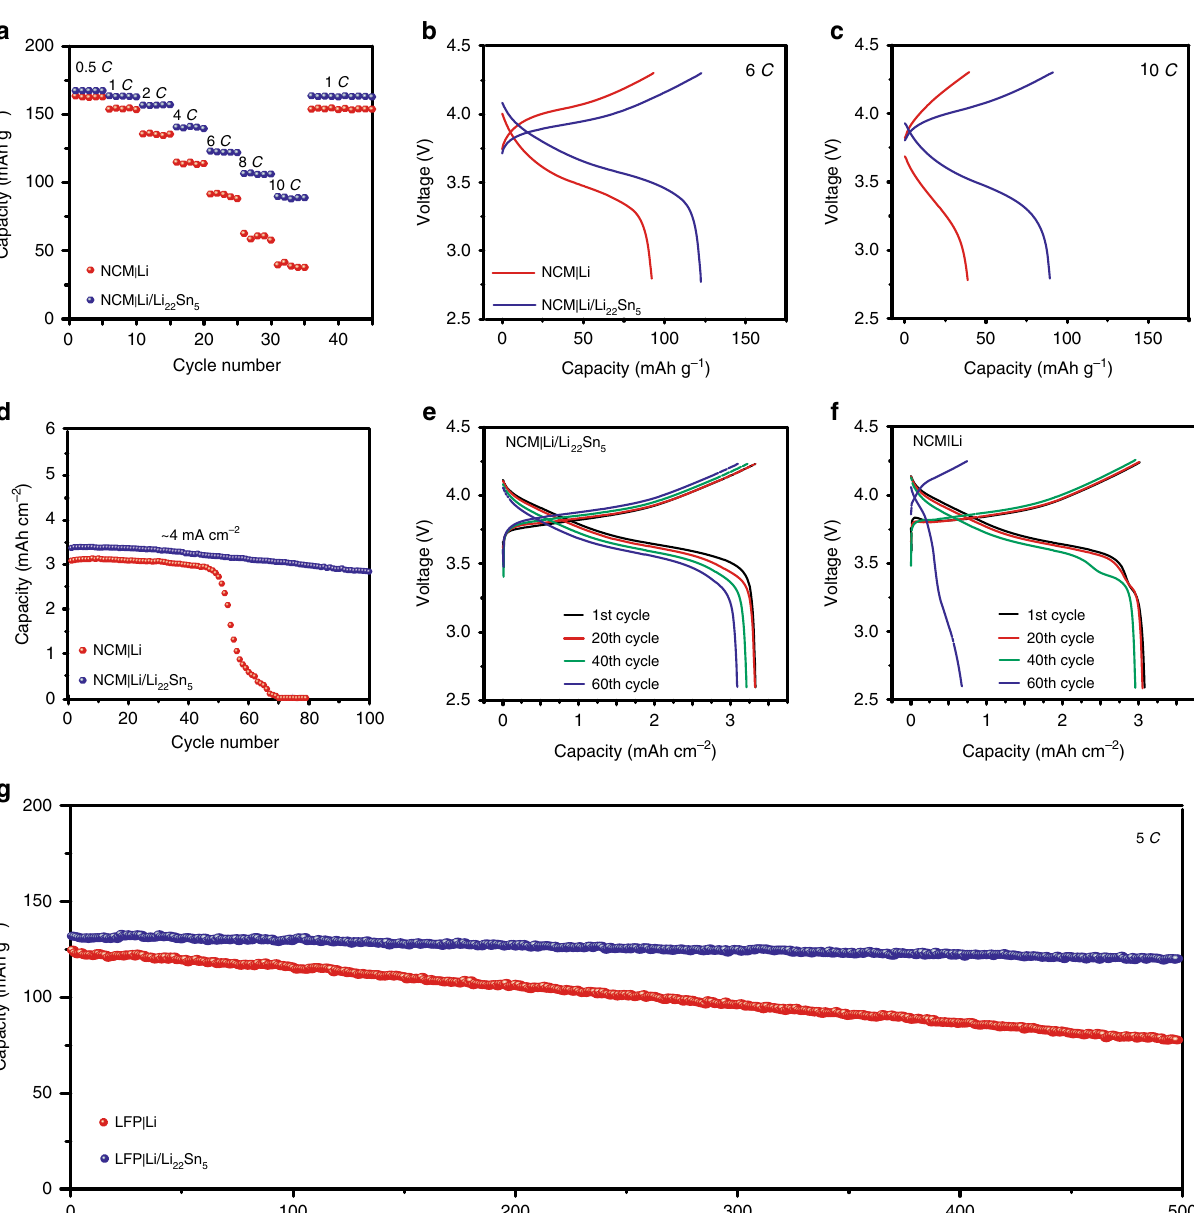
Fig. 3 Electrochemical performance of LiNi 0.6 Co 0.2 Mn 0.2 O 2 (NCM)|Li/Li 22 Sn 5 and LiFePO 4 (LFP)| Li/Li 22 Sn 5 cells. a Rate capability of the NCM|Li/ Li 22 Sn 5 and NCM|Li cells with NCM loading of ~6.5 mg cm − 2 at various rates from 0.5 to 10 C . b , c Voltage vs. capacity pro fi le comparison of the NCM|Li/ Li 22 Sn 5 and NCM|Li cells at rates of 6 C ( b ) and 10 C ( c ). d Capacity vs. cycle number pro fi les of the NCM|Li/Li 22 Sn 5 and NCM|Li cells with high NCM mass loading (~23.7mg cm − 2 ) and low areal capacity ratio of negative to positive electrodes (N/P ratio, 3.75). e , f Voltage vs. capacity pro fi les of the the NCM| Li/Li 22 Sn 5 ( e ) and NCM|Li ( f ) cells with high NCM mass loading and low N/P ratio for various cycles. g Capacity vs. cycle number pro fi les of the LFP|Li/ Li 22 Sn 5 and LFP|Li cells with LFP mass loading of ~5 mg cm − 2 at 5 C for 500